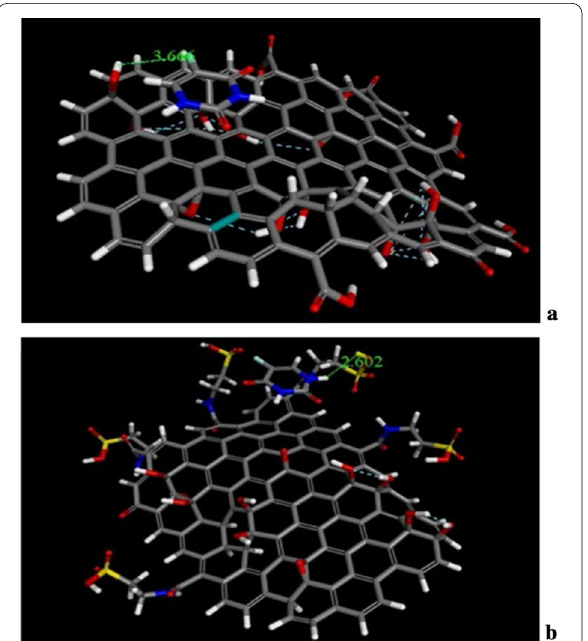
Fig. 14 The Molecular docking of GO sheets with 5-FU ( a ). The molecular docking of Tau-GO with 5-FU ( b )